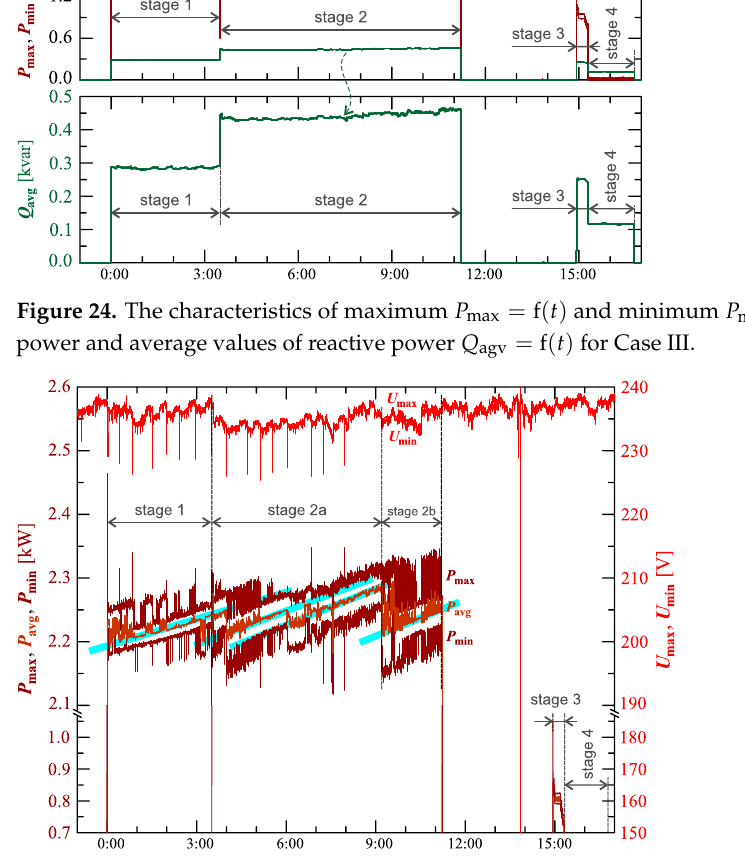
Figure 25. The characteristic of maximum P max = f ( t ) , average P avg = f ( t ) and minimum P min = f ( t ) values of active power and maximum U max = f ( t ) and minimum U min = f ( t ) rms values of supply voltage for Case III; cyan lines are added in the background to indicate the quasi-linear increase in average values of active